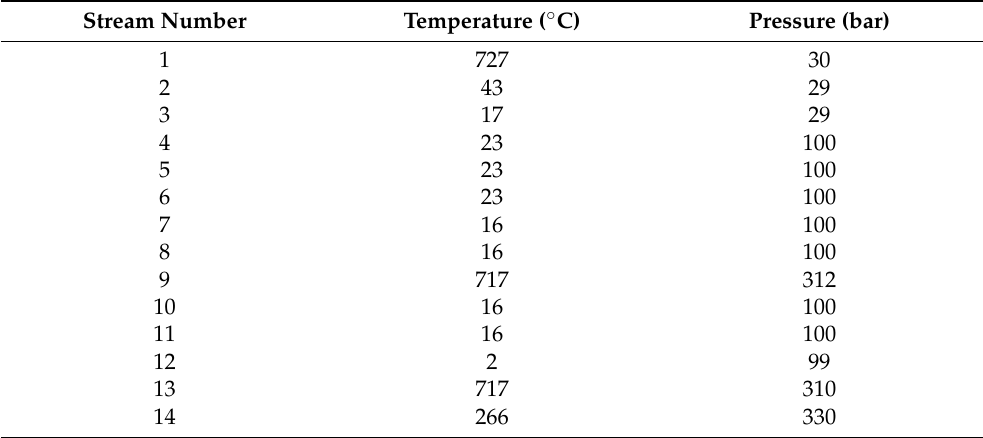
Table A1. Operating conditions related to numbered points in Figure 1 [21].